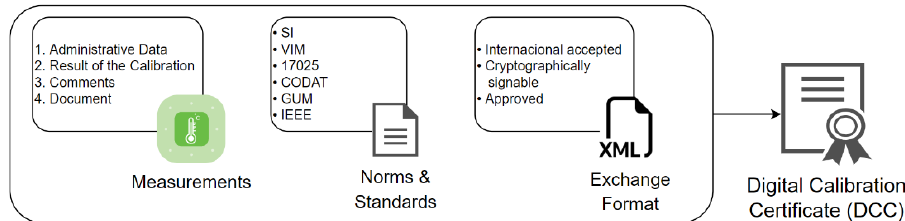
Figure 4. Structure of digital calibration certificates according to [42].